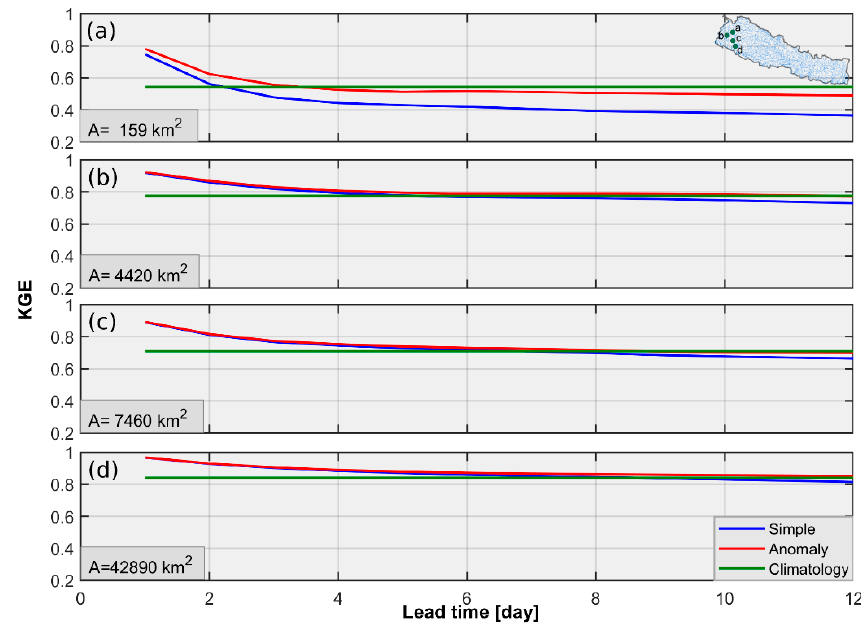
Figure 5. Evolution of KGE metric with lead time across increasing basin scales ( a )– (d ) shown in the inset. The panels show the KGE comparison between three methods: simple persistence, anomaly persistence and climatology.